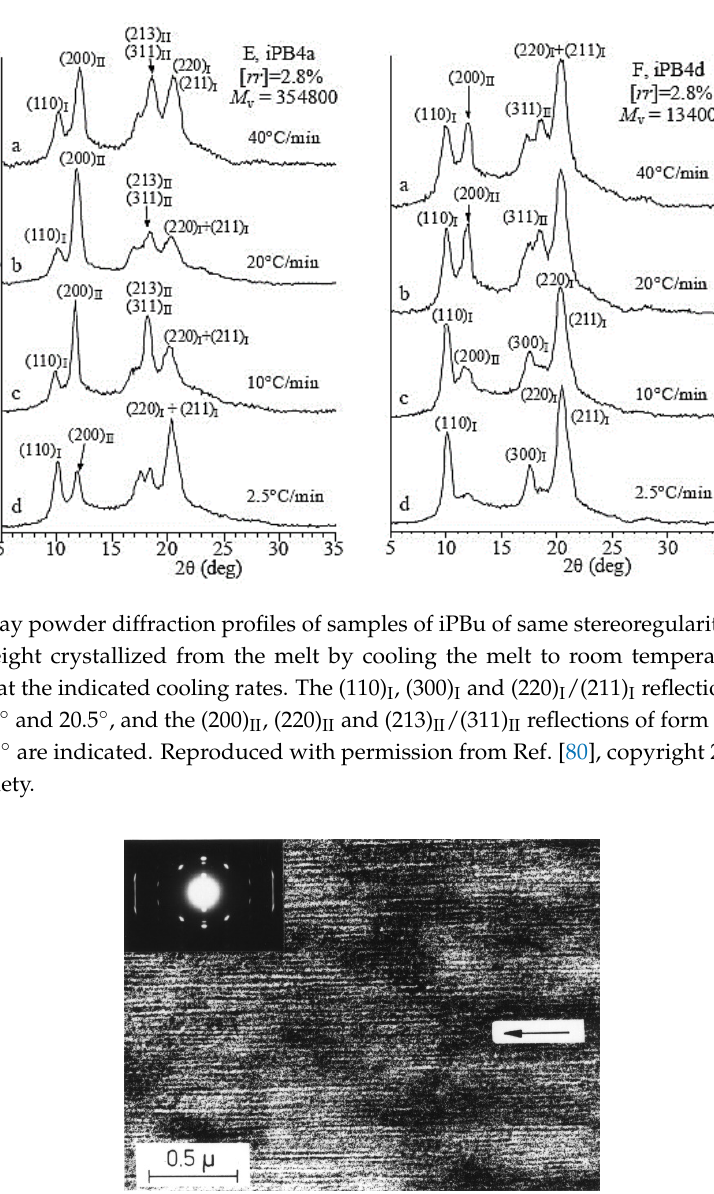
Figure 13. Phase contrast bright field electron micrograph and corresponding electro diffraction pattern (inset) of a melt-drawn iPBu ultrathin film recorded directly after sample preparation. The arrow indicates the drawing direction during film preparation. Reproduced with permission from Ref. [90], copyright 2003 American Chemical Society.